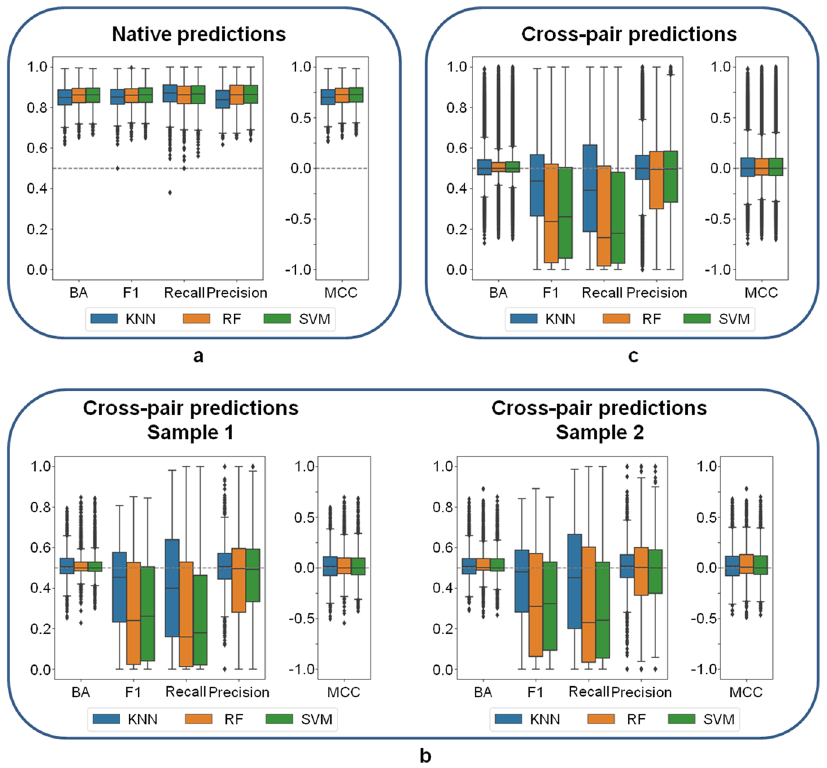
Figure 2. Model performance. Boxplots report distributions of ML model performances on the basis of different measures (KNN: blue, RF: orange, SVM: green). In a box plot, a distribution is represented by its maximum (upper whisker), upper quartile (upper boundary of the box), median (horizontal line in box), lower quartile (lower boundary of the box) and its minimum (lower whisker). Individual values classified as statistical outliers are shown as diamonds. ( a ) Models were evaluated on test sets for the same target pairs they were trained on (native model predictions). ( b ) Shown are two representative examples of models that were evaluated on test sets from different target pairs (cross-pair predictions). ( c ) Model performance is reported over all 28,730 cross-pair predictions.